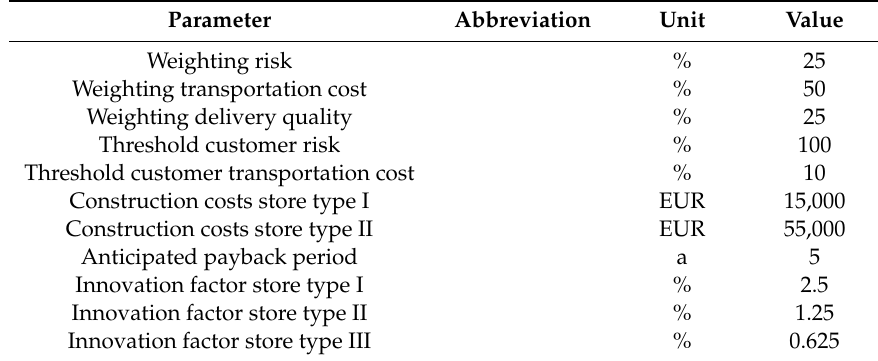
Table 3. Discrete choice model (DCM) parameters.